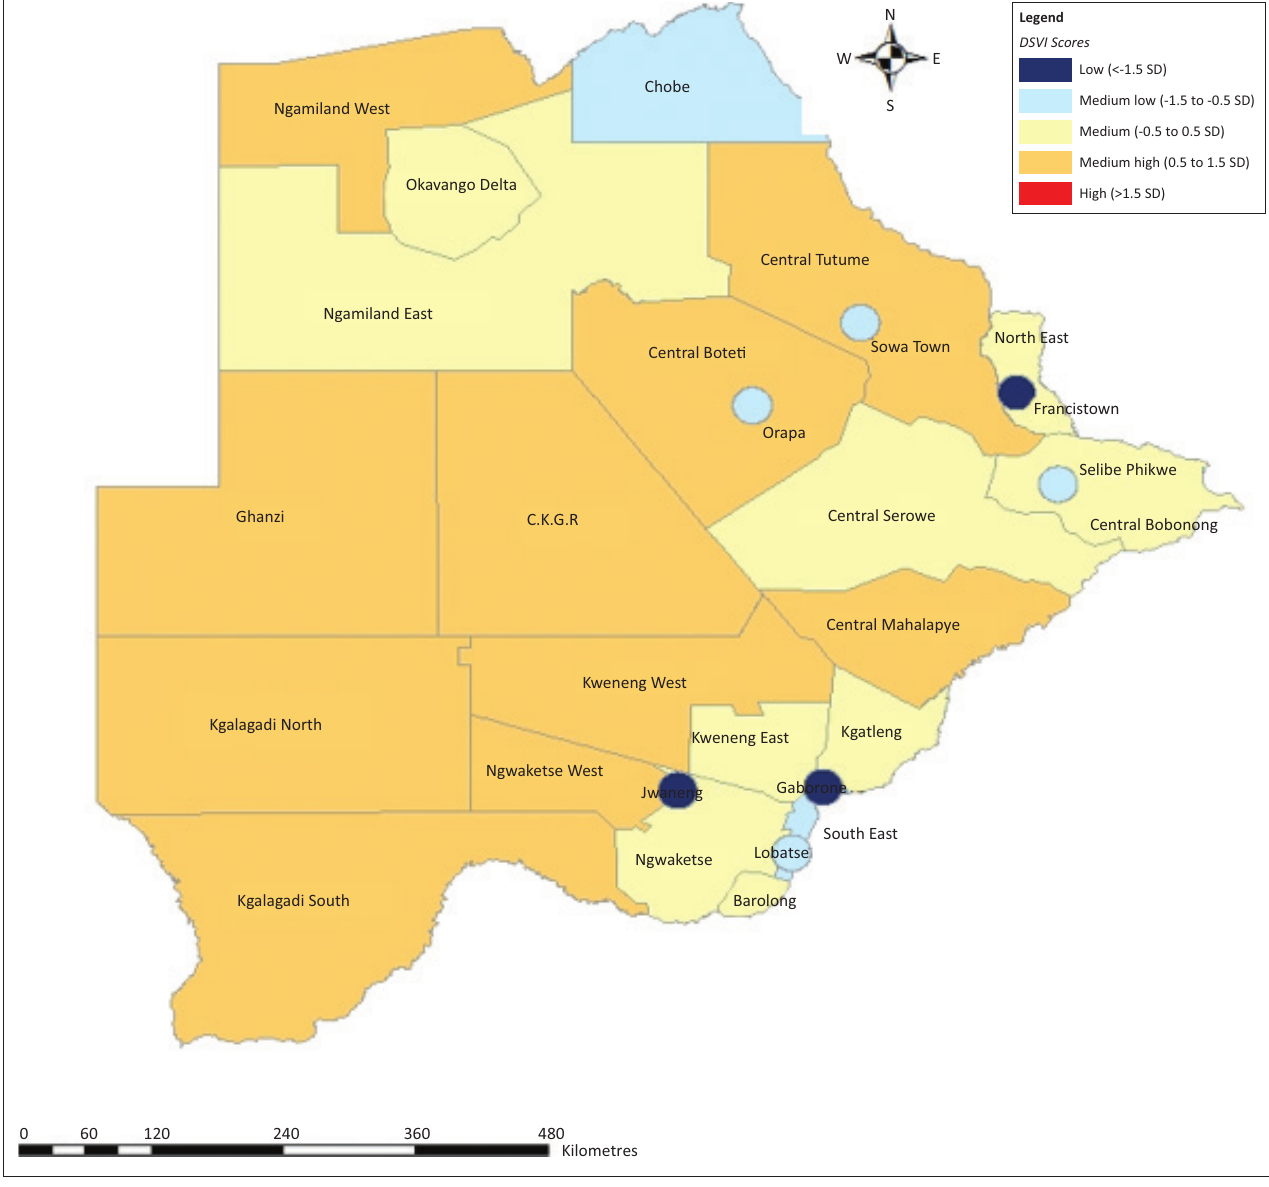
FIGURE 2: Spatial distribution of District Social Vulnerability Index scores by district in